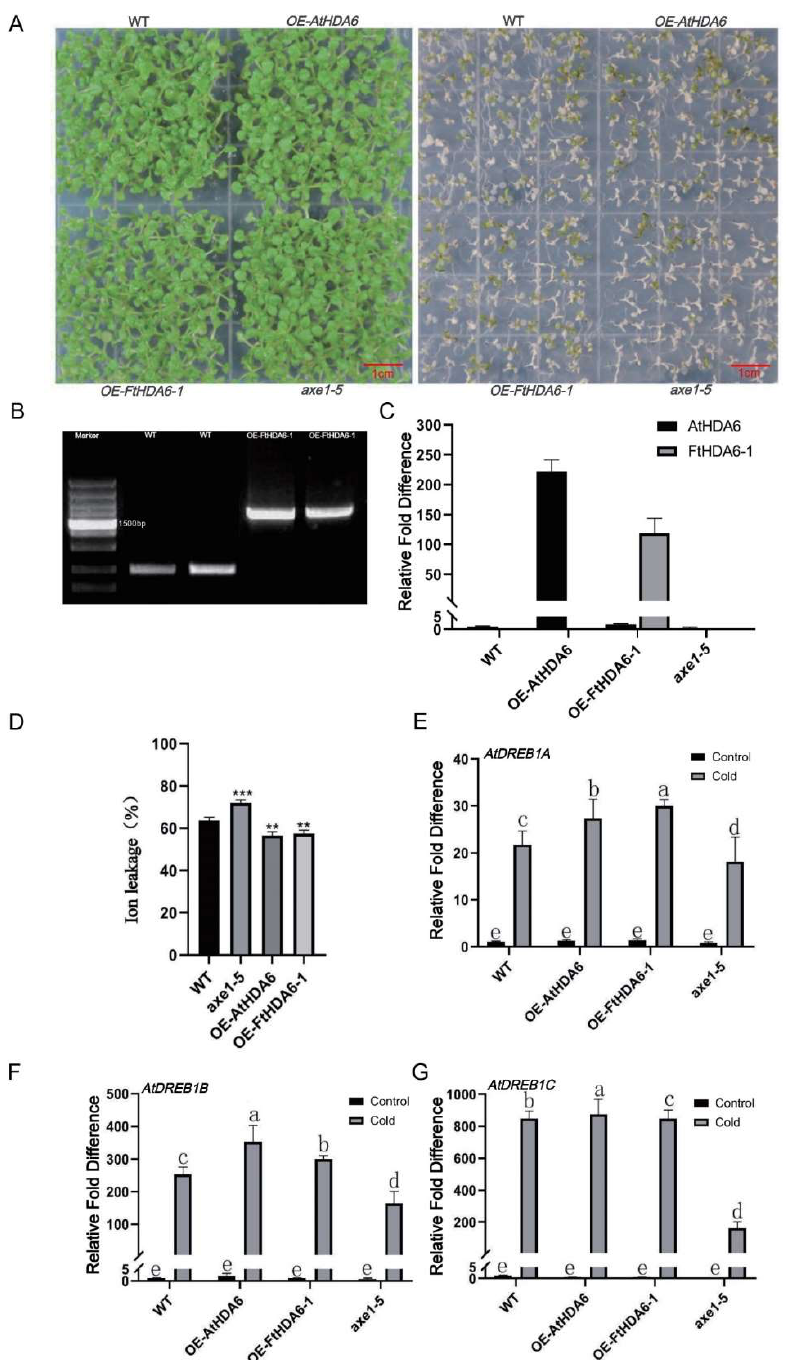
Figure 9. FtHDA6-1 positively regulates cold tolerance. ( A , D ) Phenotypes and ion leakage of seedling of WT, OE- AtHDA6 , OE- FtHDA6-1 and axe1-5 under normal and cold stress conditions (−10 °C for 2 h, then recovery in 23 °C for 2 days). Data are presented as the means of three biological replicates (±SD). The asterisks indicate significant differences, one-factor ANOVA (* * p < 0.01, *** p < 0.005). ( B ) Identification of transgenic Arabidopsis thaliana . ( C ) qRT-PCR identification the expression level of HDA6 gene in WT, axe1-5 , OE- FtHDA6-1 and OE- FtHDA6 genotypes. ( E – G ) Expression level of CBFs in different transgenic Arabidopsis lines under normal (the control) and cold stress conditions (0 °C for 3 days). Data are presented as the means of three biological replicates (±SD). Different letters indicate significant differences ( p < 0.05, Tukey’s test).